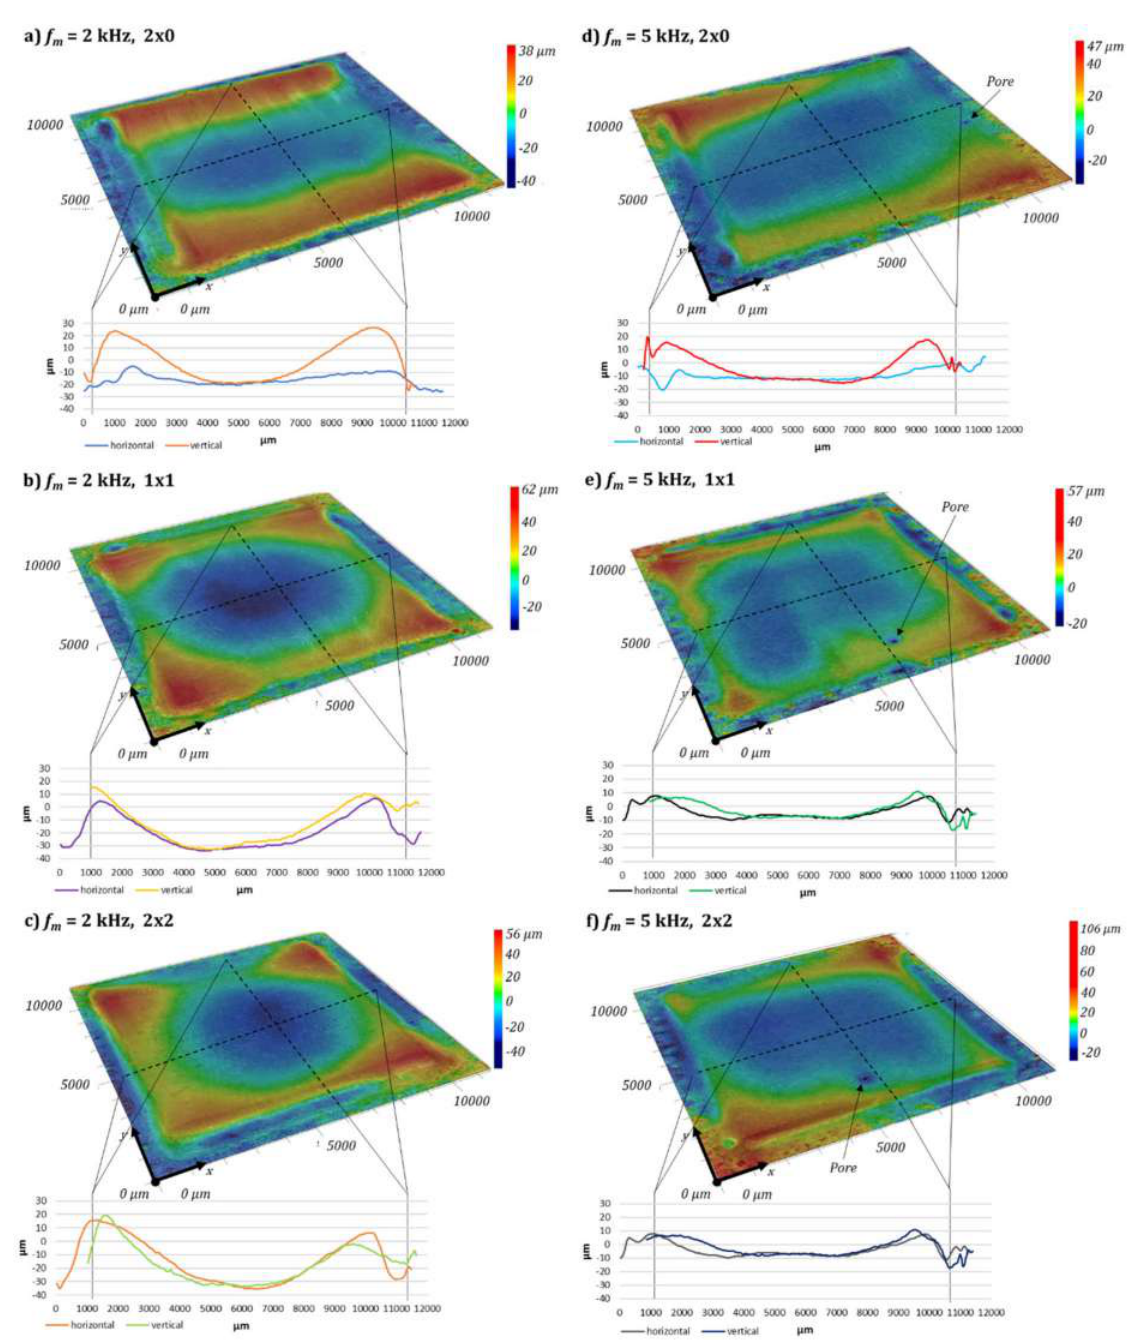
Figure 23. D topography of the laser polished surface in dependency of the number of polishing passes n for a modulation frequency of f m = 2 kHz ( a – c ) and f m = 5 kHz ( d – f ) under a 12-fold